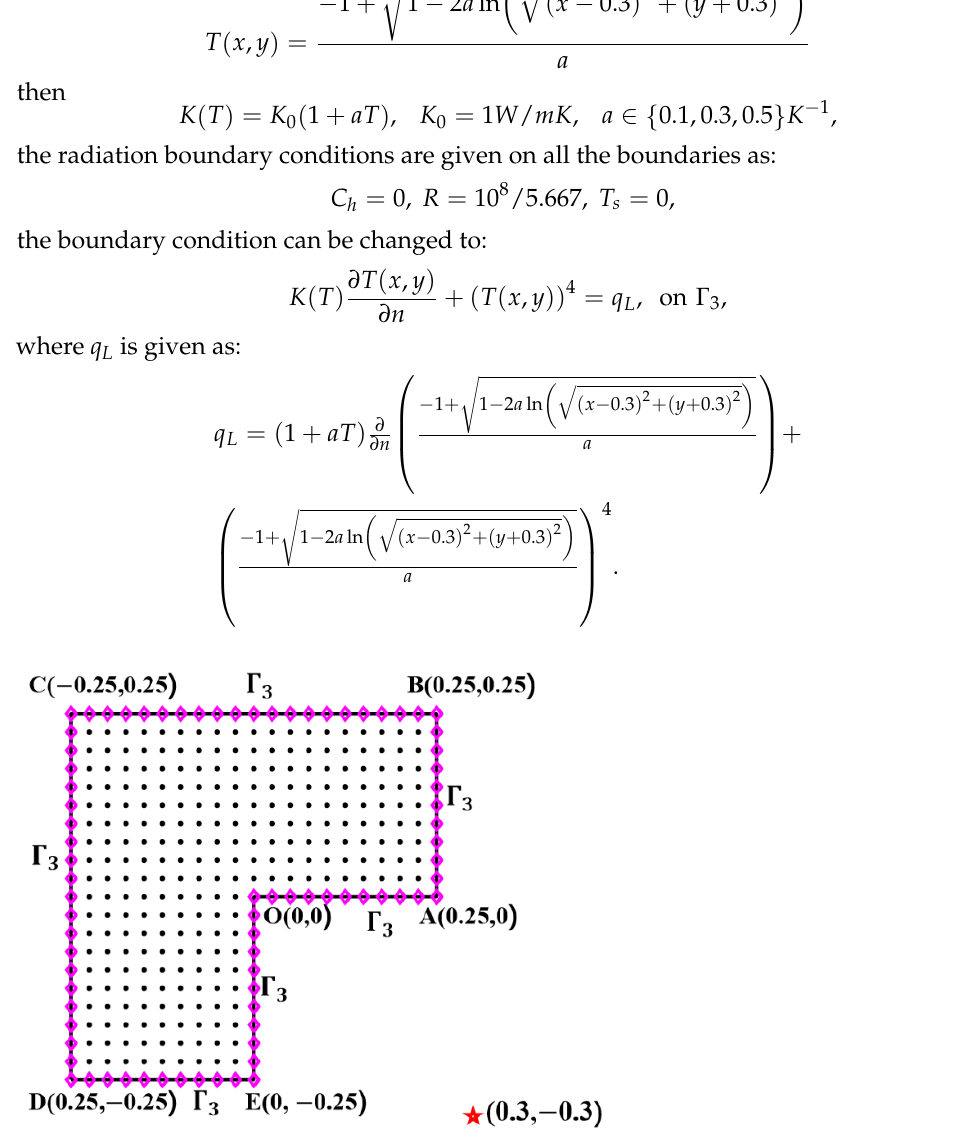
Figure 7. Schematic of the computational domain of case 3.